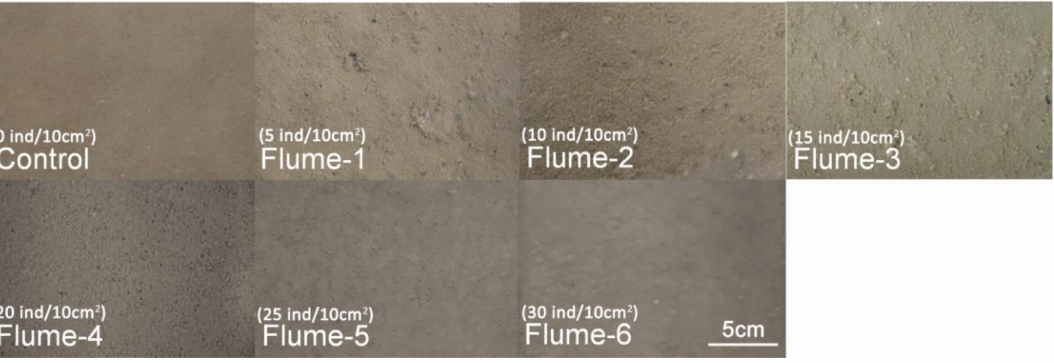
Figure 4. E ff ect of bioturbation on the sediment surface under seven biological densities.